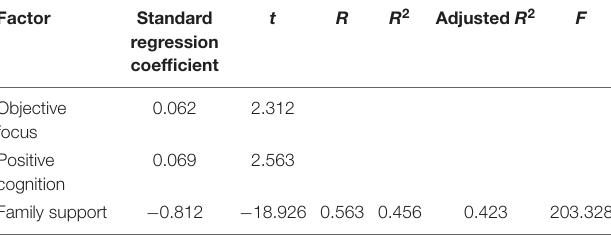
TABLE 9 | Regression analysis of mental toughness to self-harmony.